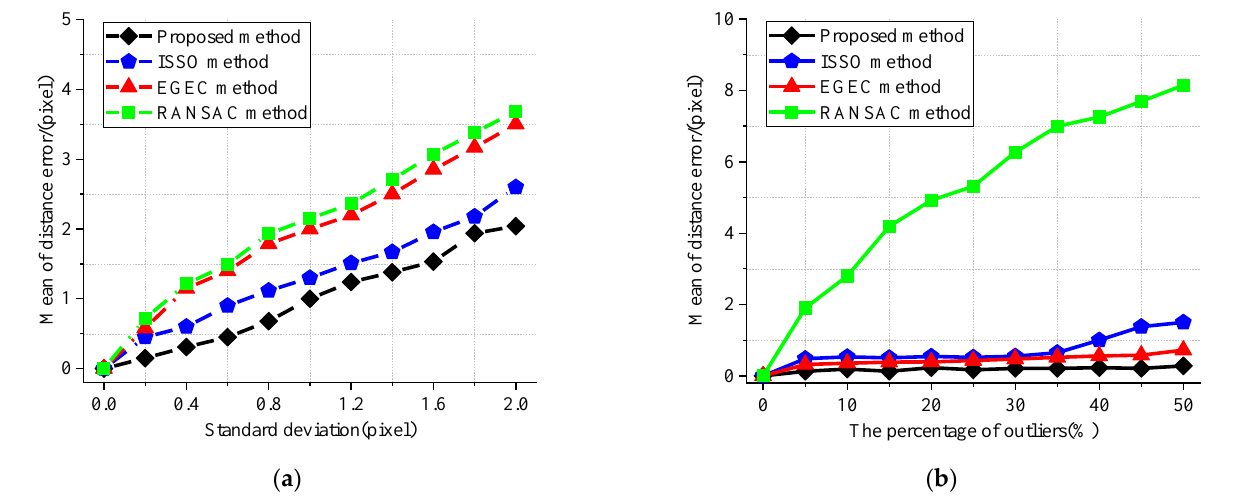
( b ) Figure 5. Comparisons of the epipolar geometric distances. ( a ) The mean geometric distance with varying Gaussian noise; ( b ) The mean geometric distance with varying outliers proportion.